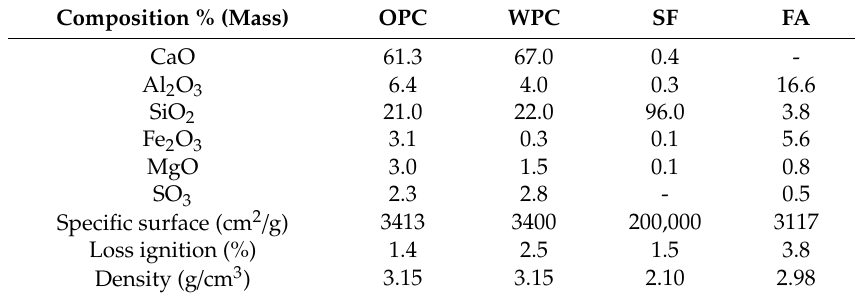
Table 4. Chemical compositions and physical properties of the cementitious